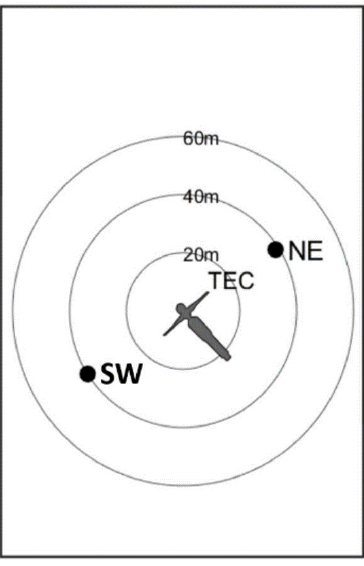
Figure 1. Location of turbine (TEC) and two recording devices used in the ReDAPT project, obtained from [13], data used here from the device at the North East location (NE).